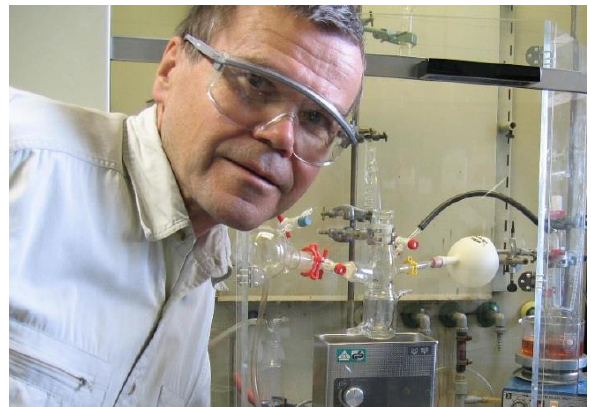
Figure 8. Heiner Eckert at the laboratory [J] .